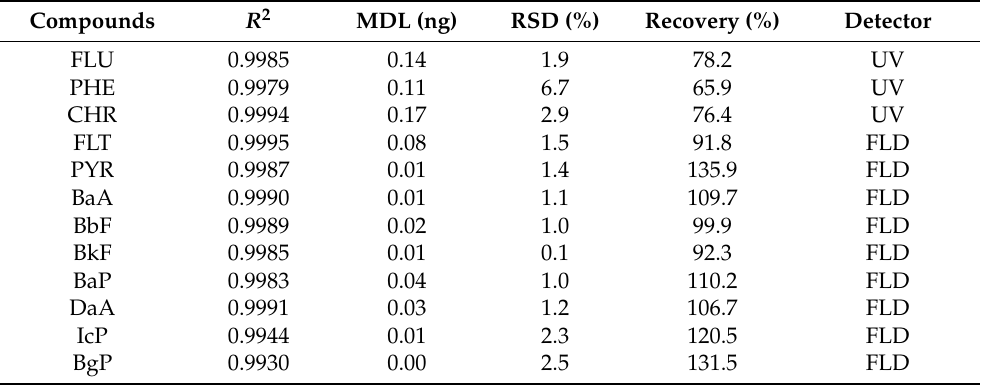
Table 2. QA/QC results for PAH analysis. Note that RSD indicates relative standard deviation.